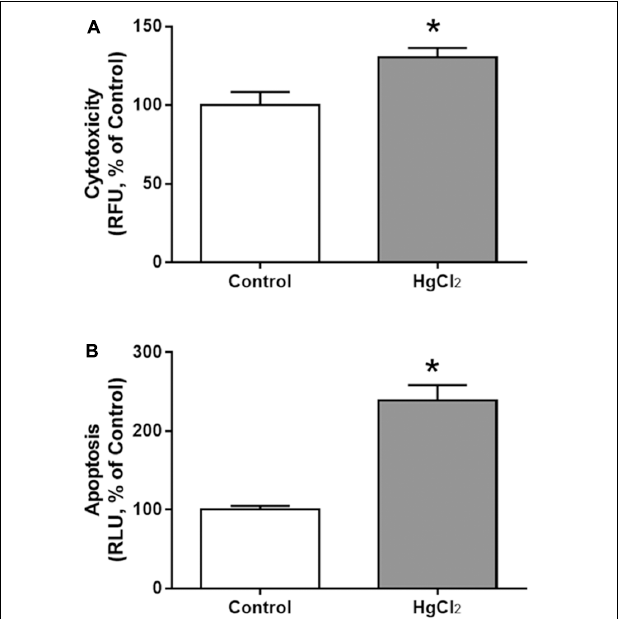
FIGURE 7 | Effects of chronic exposure to HgCl 2 on cytotoxicity and induction of apoptosis in the motor cortex of adult Wistar rats. The results are expressed as mean ± standard error of the (A) percentages of cytotoxicity at relative fluorescence units (RFU) relative to the control group and (B) percentages of apoptosis at relative luminescence units (RLU) in relation to the control group. ∗ p < 0.05 compared to the control group (Student’s t -test).